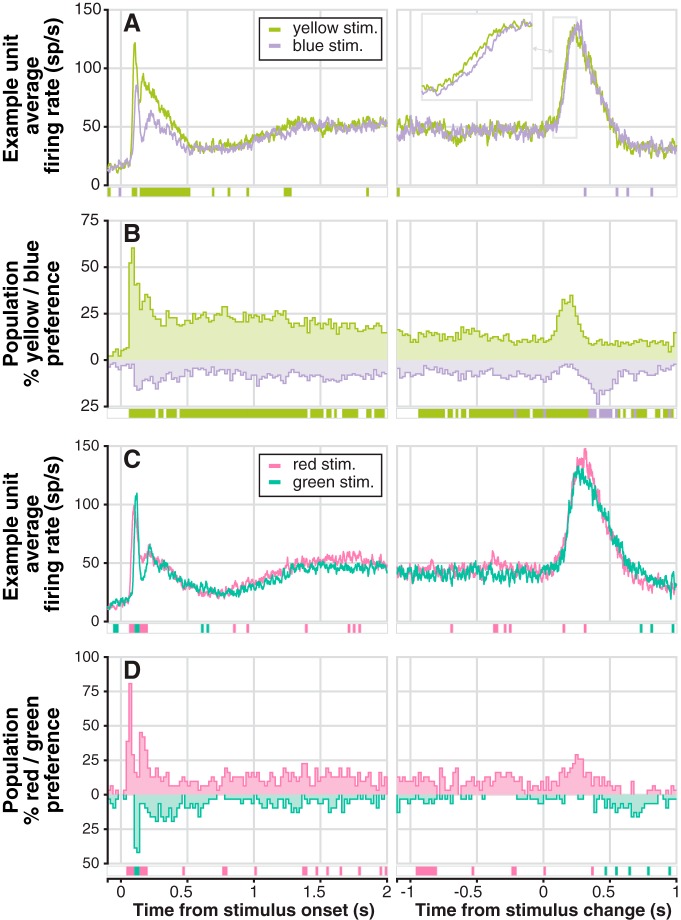
Example unit and population-level color preferences between color-pairs. A, Example unit average firing rate traces aligned on stimulus onset (left) and color change (right), for yellow and blue stimuli. Significant preferences for one of the two colors in each bin is indicated by the row of colored boxes below; significance was determined using bootstrapped ROC areas comparing spike counts from nonoverlapping 20 ms bins (see Materials and Methods). Right panel inset shows a time-expanded view of the outlined rising portion of change-related phasic activity. B, Population-level percentage yellow/blue preference (n = 139): the percentage of individual units with a significant preference in each bin; the row of colored boxes below mark bins in which the proportion of units preferring one of the colors was significantly greater than the proportion preferring the other as measured by χ2-proportion tests. C, Example unit average firing rate traces for red and green stimuli (conventions as in A). D, Population-level percentage red/green preference (n = 31): conventions as in B.